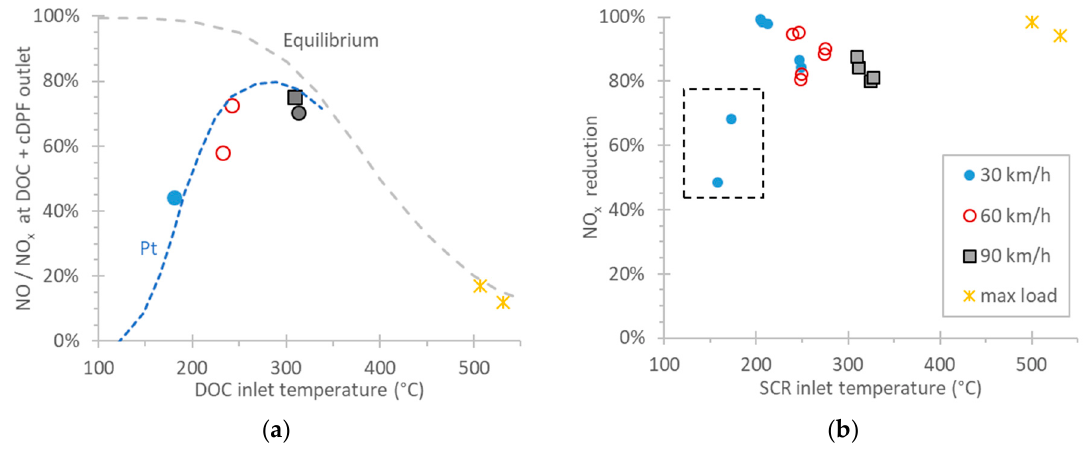
Figure 5. NO x conversions in the aftertreatment device: ( a ) NO to NO x ratio at the outlet of the DOC + cDPF as a function of the exhaust gas temperature in the DOC inlet. Circles are the measured data. The blue dotted line is a typical curve for the Pt catalyst and the grey dashed line is the equilibrium; ( b ) NO x reduction efficiency in the SCR + ASC for NO x as a function of the exhaust gas temperature in the SCR inlet. The points in the square are tests after a warm start (coolant temperature 55 °C). DOC = Diesel oxidation catalyst; cDPF = catalyzed Diesel particulate filter; SCR = selective catalytic reduction.